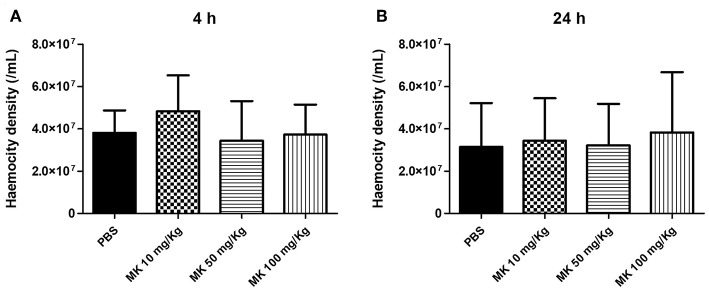
Effect of different doses of MK58911 (10, 50, and 100 mg/Kg) on haemocity density of G. mellonella larvae at (A) 4 h and (B) 24 h. Three independent experiments were performed for haemocity density, which resulted in total of 15 larvae/group.